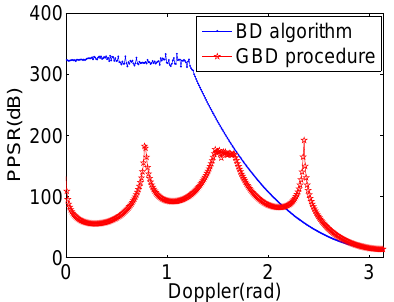
Figure 9. The comparison of PPSR between the BD algorithm and the GBD